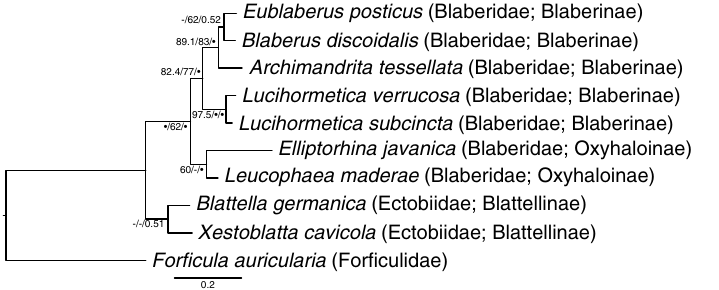
Figure 4. Phylogenetic tree of the host taxa inferred from the deduced amino acid alignment of the mitochondrial cytochrome c oxidase II. The topology is based on maximum-likelihood and Bayesian analyses (see “Methods”), and branch support is given by SH-aLRT/UFBoot2/Bayesian posterior probabilities. Black circles indicate support values ≥ 99% or ≥ 0.9, and dashes indicate values < 50% or < 0.5. The amino acid sequence of Xestoblatta cavicola has been added to sustain the sister-relationship of Blattellinae and Blaberidae 18 . The tree is rooted on Forficula auricularia